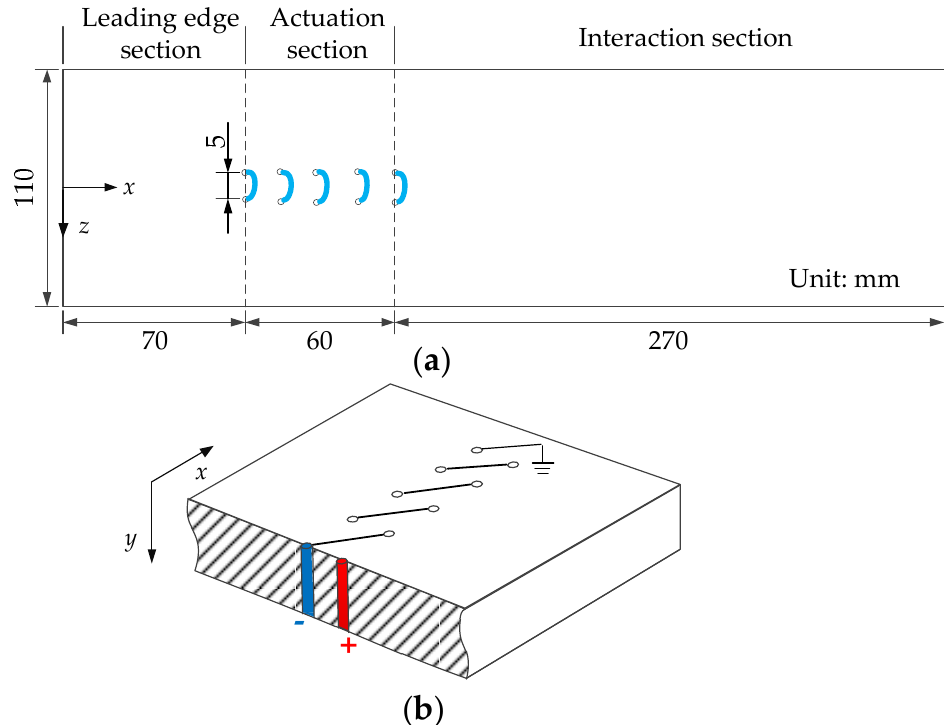
Figure 2. Schematic diagram of experimental model. ( a ) plate model ( b ) The connection of the pulsed arc discharge plasma actuator